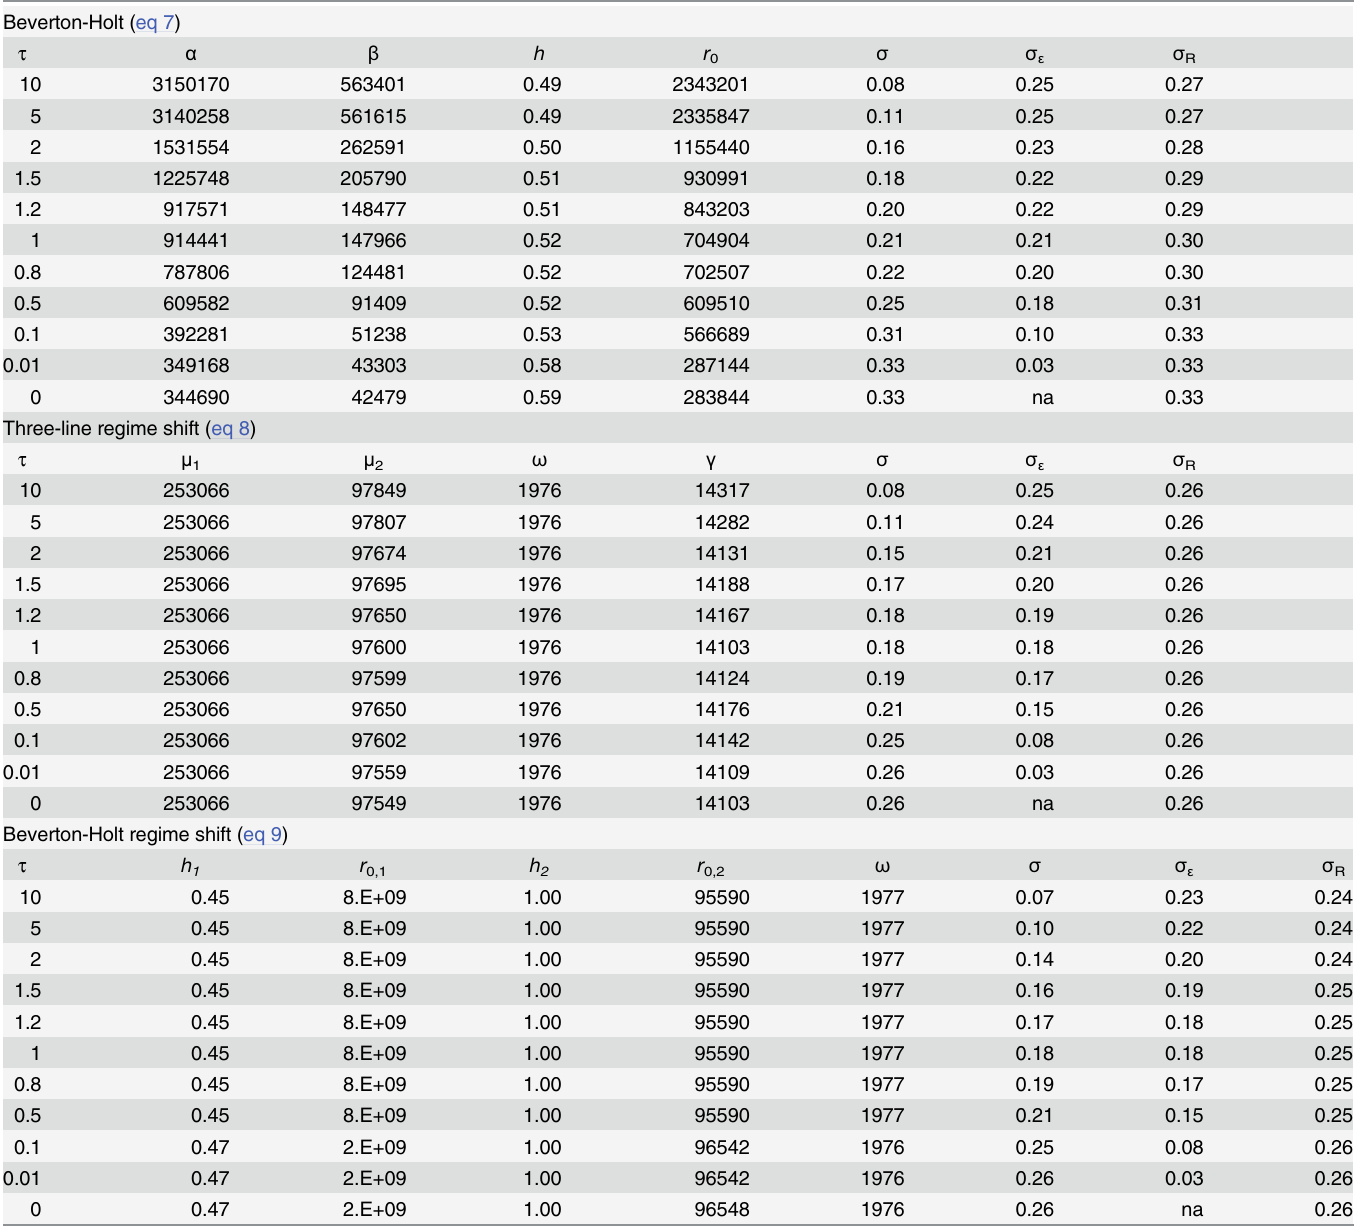
Table 2. Parameter estimates for the Beverton-Holt, three-line regime shift and Beverton-Holt regime shift models fitted to the spawning stock bio- mass and recruitment estimates from the 2014 assessment of western Atlantic bluefin tuna. Beverton-Holt (eq